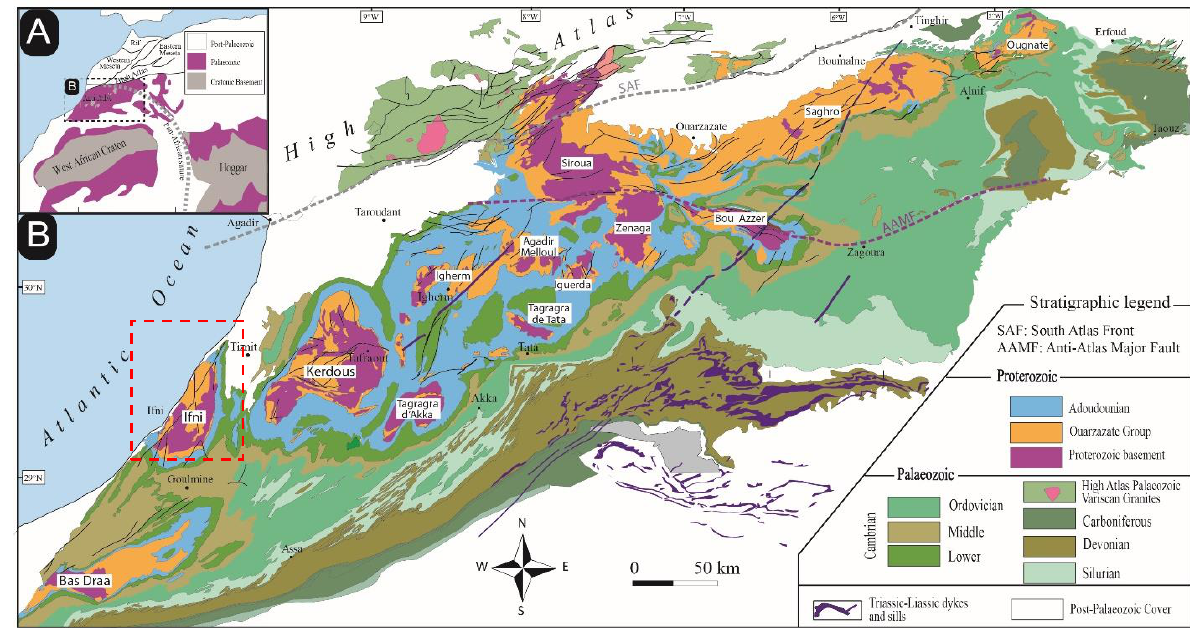
Figure 2. Schematic geological map of the Precambrian inliers of the Anti-Atlas range (modified after